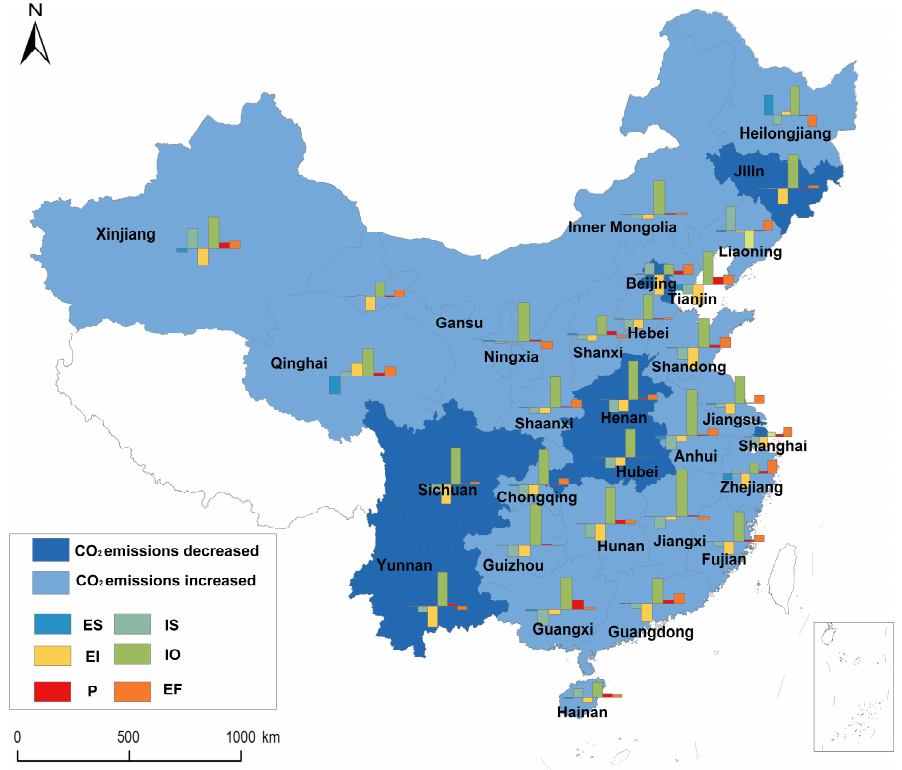
Figure 1. LMDI decomposition results of industrial CO 2 emissions of regions during 2010–2017. ES: energy structure; IS: industrial structure; EI: energy intensity; IO: per capita industrial develop- ment level; P: